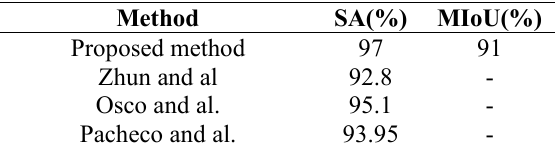
Fig. 10. Accuracy